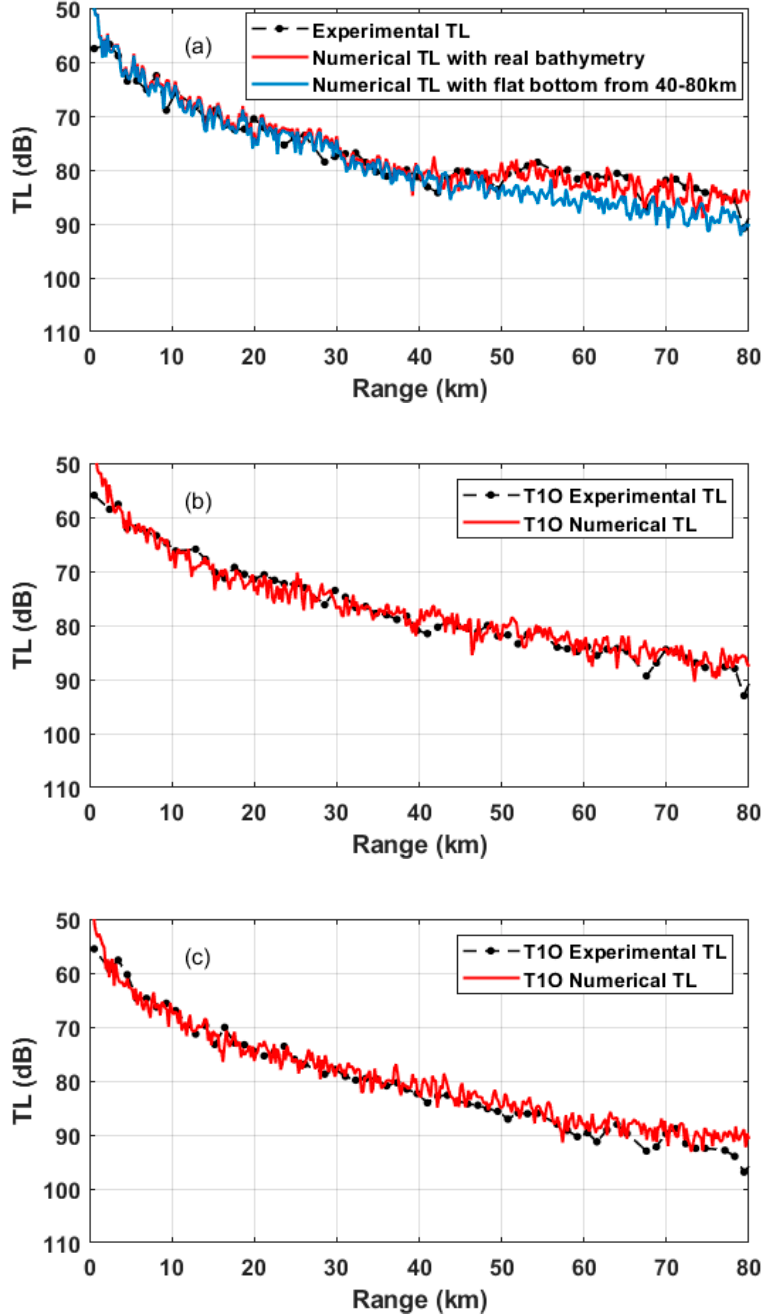
Figure 10. Comparison of numerical TLs result of T1O for central frequency 1000 Hz and source depth 7 m. ( a ) Comparing TLs of T1O with different bottoms, receiver depth is 11 m, ( b ) 37 m, and ( c ) 71